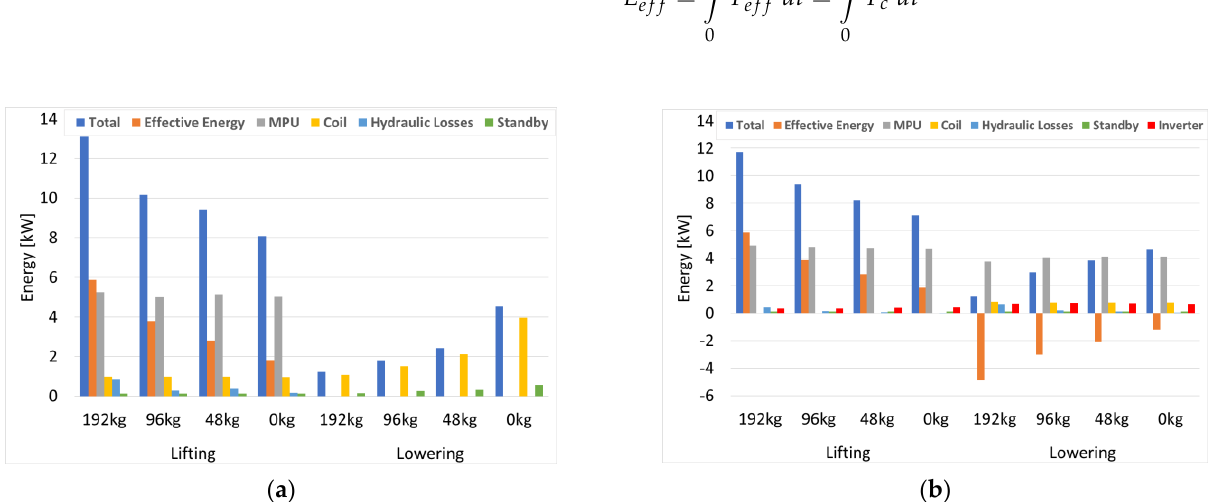
Figure 6. Energy consumption distribution: ( a ) conventional drive, ( b ) EHD.